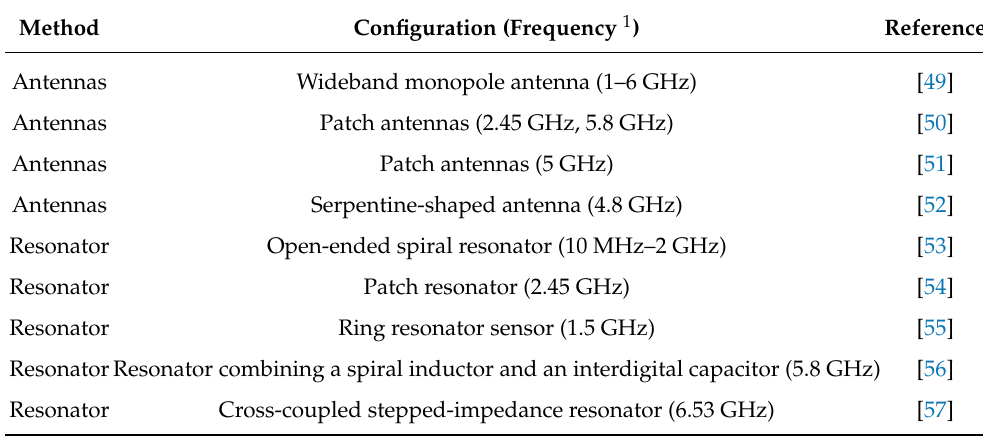
Table 2. Dielectric measurements of aqueous glucose solutions via RF spectroscopy